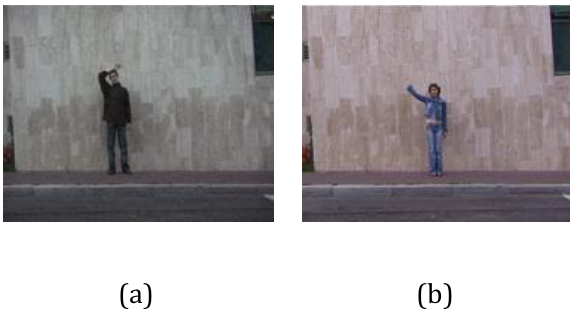
Figure 8. Abnormal “SHTW” actions. ( a ) Misclassification example; ( b ) Un-Classification